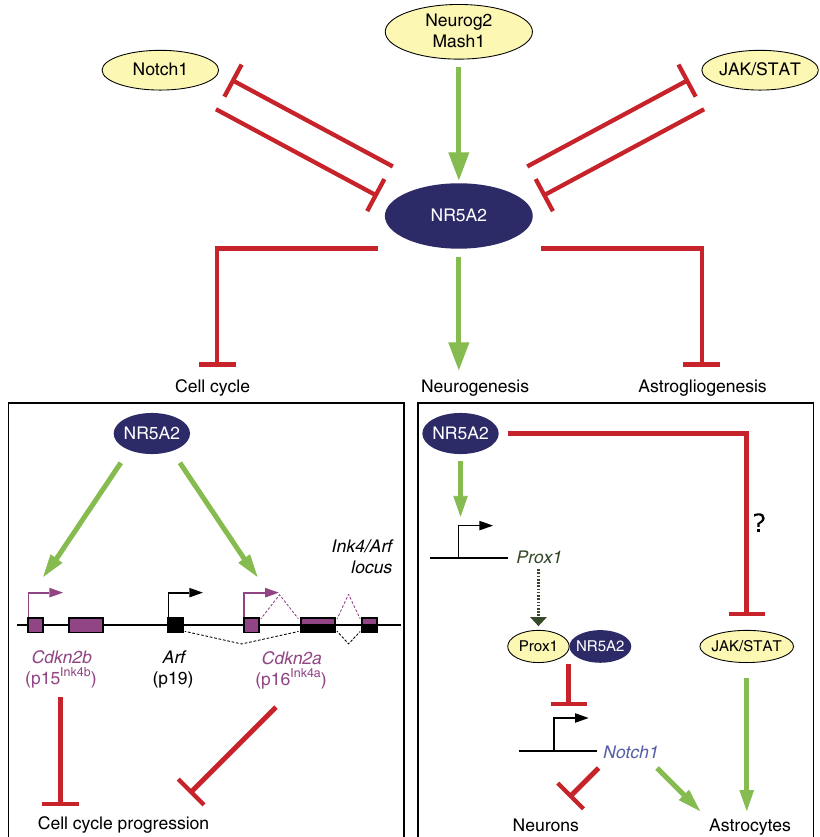
Figure 10 | Schematic representation of our proposed model for the central role of NR5A2 in NSC fate specification. NR5A2 is upstream regulated by the major neuronal and astrocytic pathways including proneural genes ( Neurog2 and Mash1 ), Notch1 and JAK/STAT signalling. On the other hand, NR5A2 regulates proliferation and differentiation of NSCs via direct regulatory effects on Ink4 / Arf locus ( p16 Ink4a and p15 Ink4b ), Prox1 as well as Notch1 and